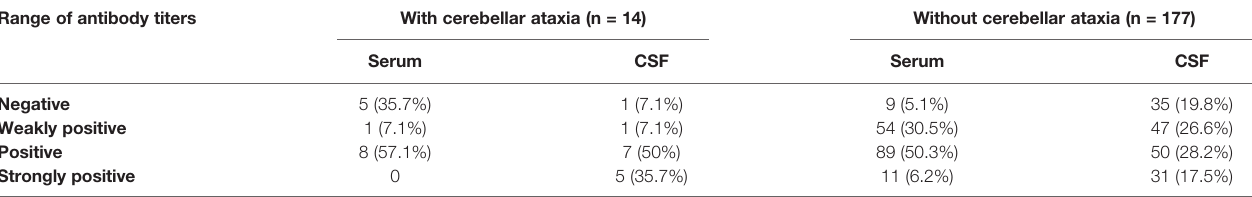
TABLE 5 | The levels of antibodies titers in patients with anti-NSAbs-associated CAs. Range of antibody